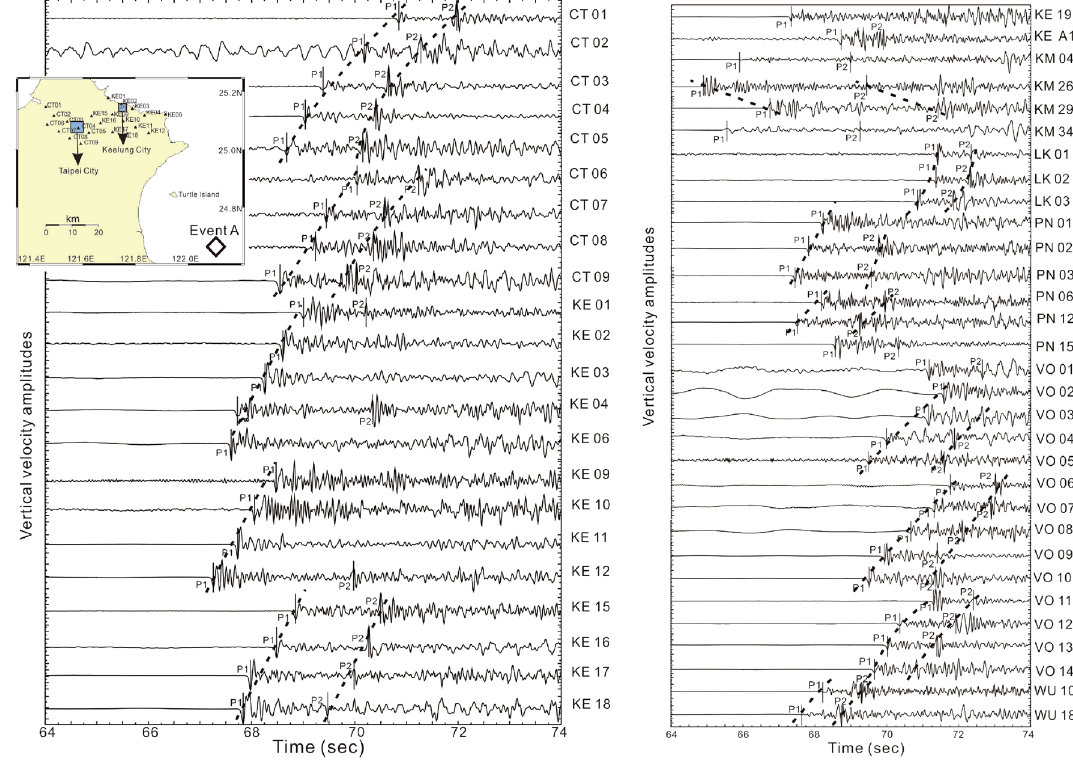
Figure 3. Arrivals of P1 and P2 (vertical bars) generated by Event A and recorded at the Formosa Array. The dashed lines mark the alignment of P1 and P2 arrivals at the adjacent stations. The insert map shows locations of seismic stations (triangles) and Event A (diamond). This figure was created by SAC software (version 101.5; URL: